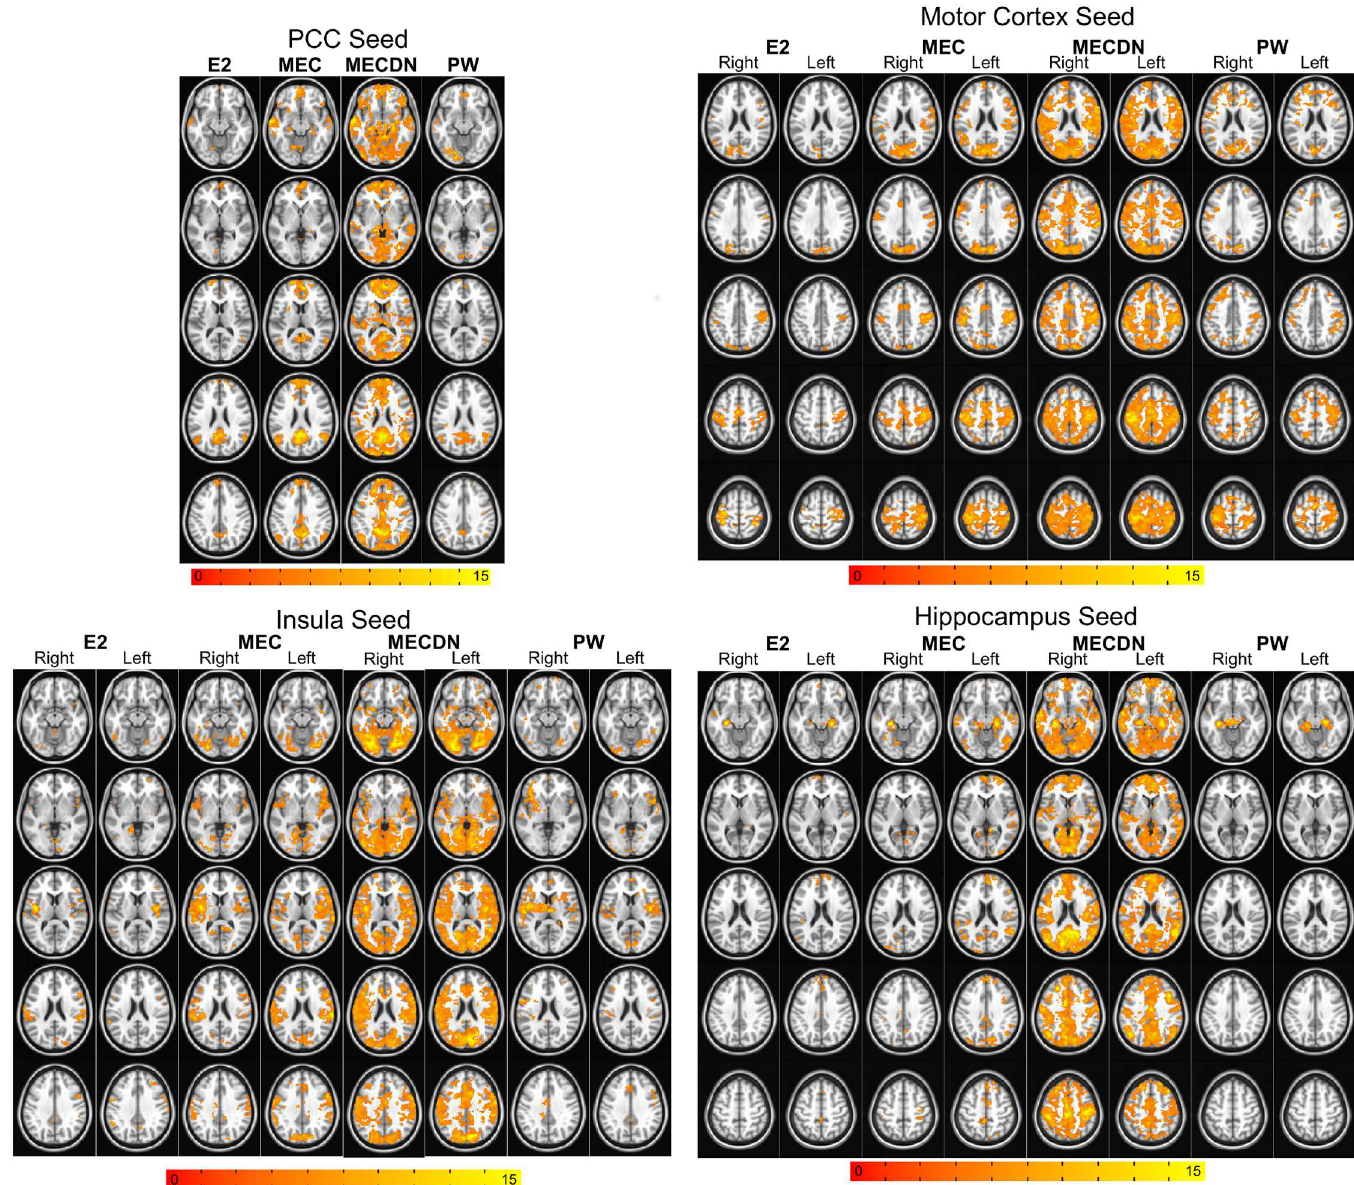
Fig 5. Group seed-based functional connectivity maps. Connectivity maps are displayedfor PCC, L/R motor cortex, L/R insula, and L/R hippocampus seeds. Maps are the result of a one-sample t-test on the Fisher-transformed z-scores and were thresholded at P < 0.005 with minimumcluster size = 46, α = 0.05. For all seed regions, connectivity was markedly increasedin terms of network size and correlation strength for the MECDN datasets comparedto the others. Limited insula and hippocampus connectivitywas observedfor the E2 and PW datasets. Bilateralinsular connectivity was seen for the MEC dataset. The MECDN data producedsignificantbilateralconnectivitywith long-range connections for both the insula and hippocampus seeds. Robust connectivity was detected with the PW data for the PCC and motor network seeds. Some bilateral connectivity was seen for the insula